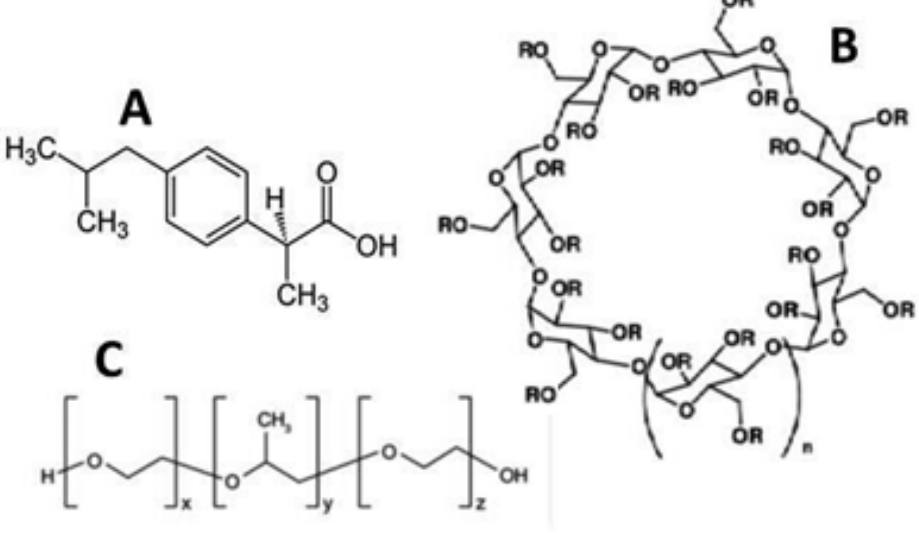
Figure 1. Chemical structure of ( A ) DEX, ( B ) HP β CD and ( C ) poloxamers. Note: x, y and z are hydrophilic ethyleneoxide (EO), hydrophobic propyleneoxide (PO) and hydrophilic (EO)